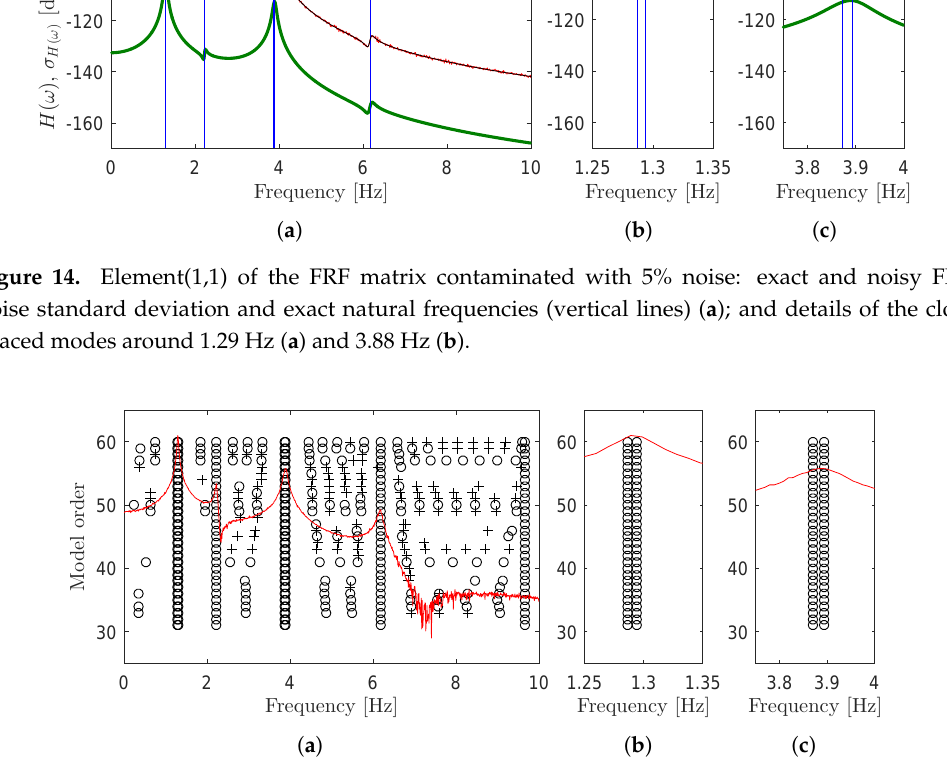
Figure 15. Typical stabilization diagram constructed with the LSCF for model orders ranging from 30 to 60.